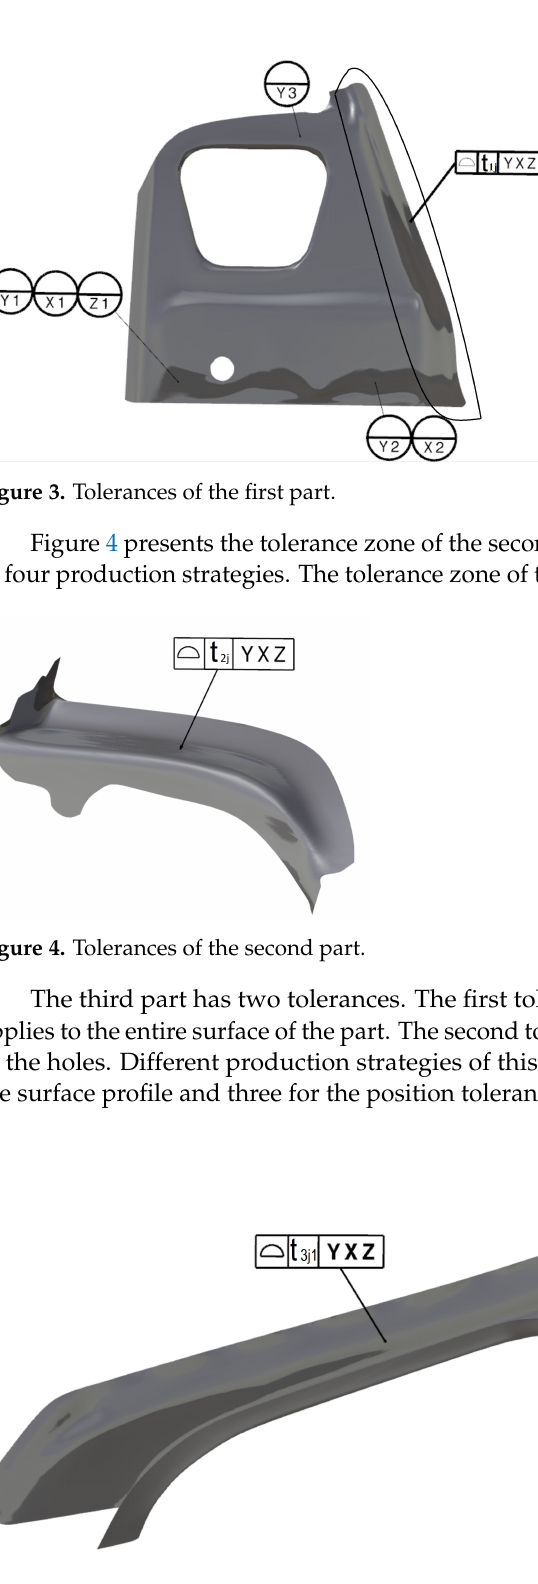
Figure 5. Tolerances of the third